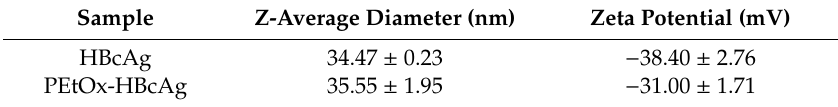
Table 1. Z-average diameter and zeta potential of HBcAg and PEtOx-HBcAg VLNPs.